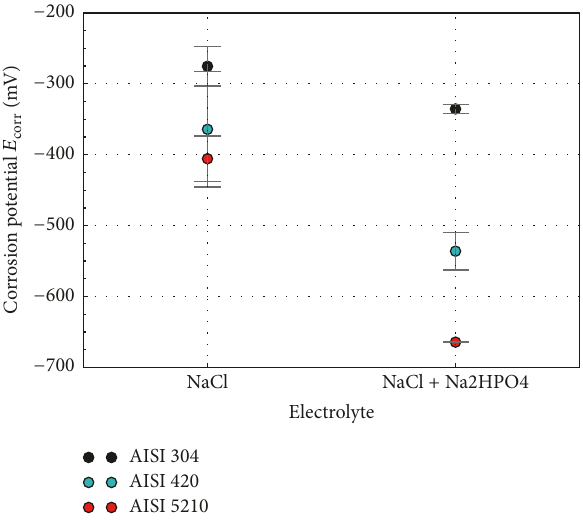
Figure 9: Corrosion potentials and its standard deviations of AISI 304, 420, and 5210 measured in NaCl solution and phosphate buffer with NaCl. 𝜎 = √(1/(𝑛 − 1)) ∑(𝑥 𝑖 − 𝑥) 2 , 𝑛 = 4